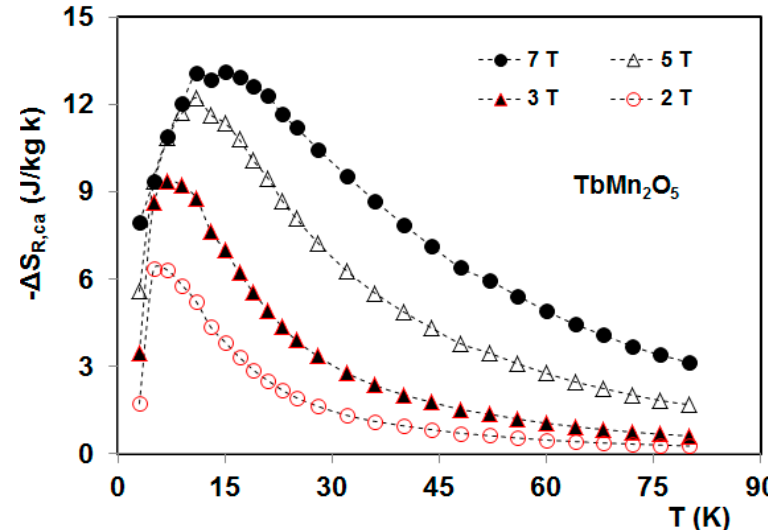
Figure 16. Rotating entropy change as a function of temperature for the single crystal TbMn 2 O 5 in several constant magnetic fields, initially parallel to the c-axis [20].